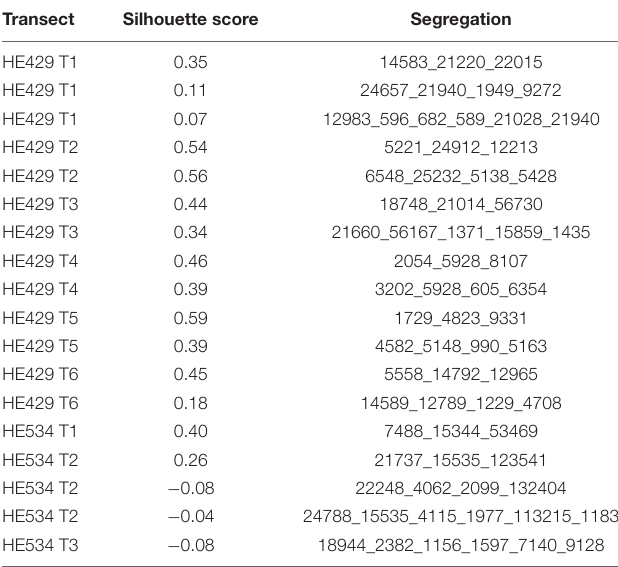
BL did not change much between 3 and 4